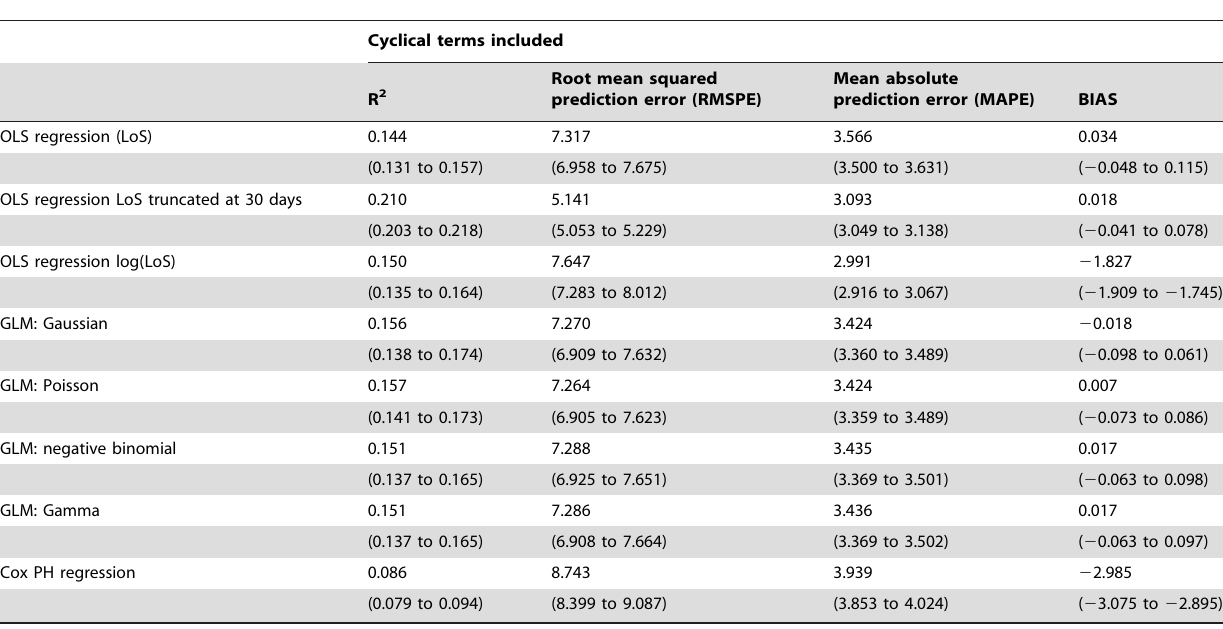
Table 5. Estimated performance of regression models, when constructing models using all patients and cyclical terms.